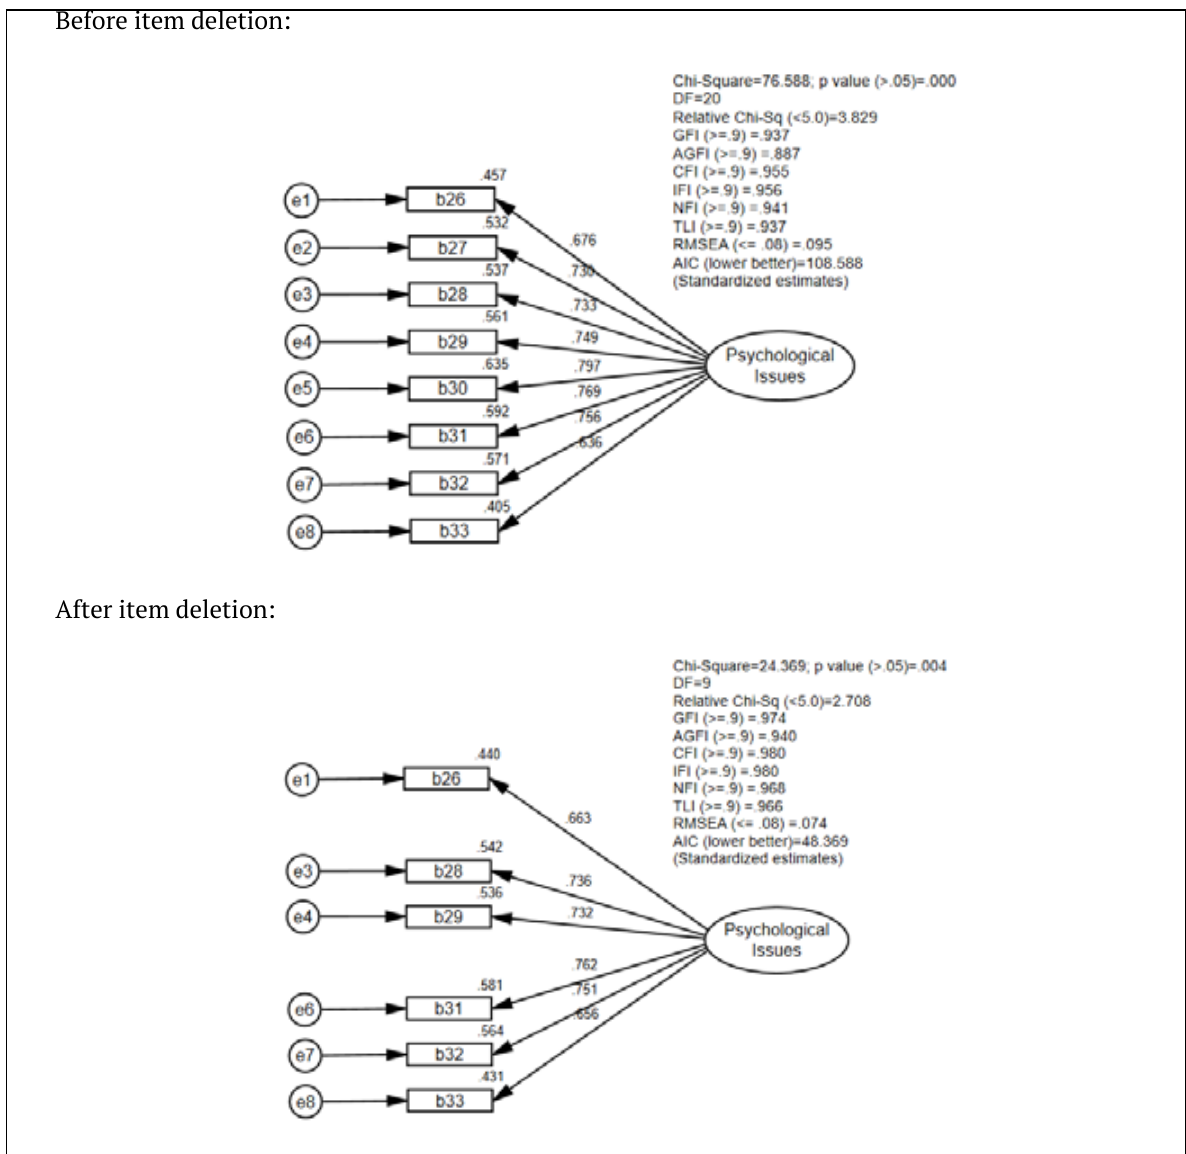
Figure 4. Confirmatory Factor Analysis for Psychological Issues with stress, difficulty overcoming drowsiness, and difficulty coping with pain from injury. While the fifth construct is related to interpersonal issues such as conflict with the coach, conflicts with teammates, conflict with management, and conflict with family. These constructs resemble the idea that athletes who participate in sport at a high level will likely experience a number of stressors, adversities, and failures [43, 44,